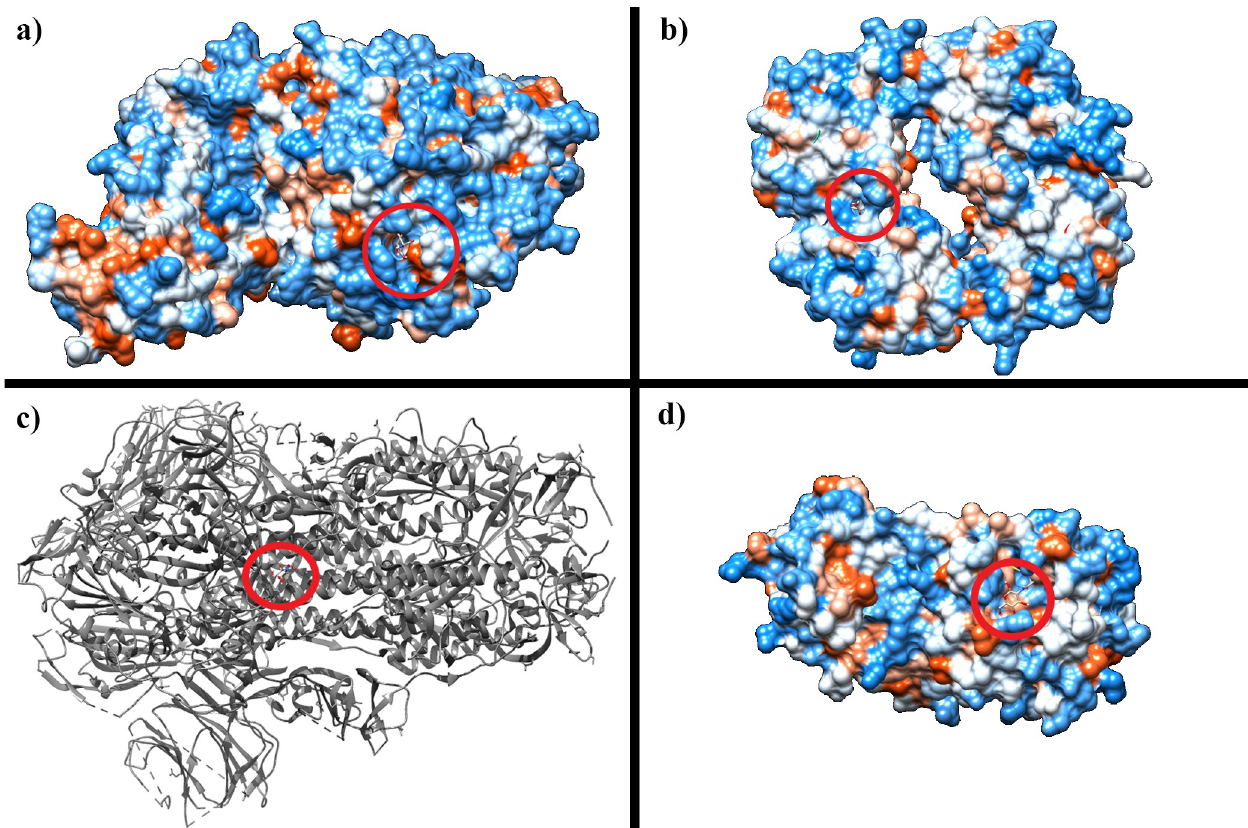
Fig 2. Best docking poses for tested proteins. Hydrophobicity surface representation of the best docking pose with D-GlcNAc for a ) 6M0J, b ) 6WKP, d ) 7JVZ and ribbon representation to the best docking pose with D-GlcNAc for c ) 6X79. Red circles showing where D-GlcNAc is positioned within the protein. Figures were produced with UCSF